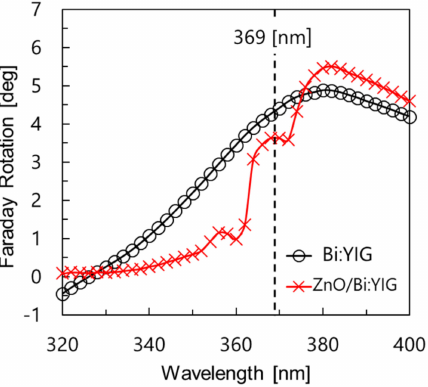
Figure 6. Faraday rotation spectra of Bi:YIG and ZnO/Bi:YIG.